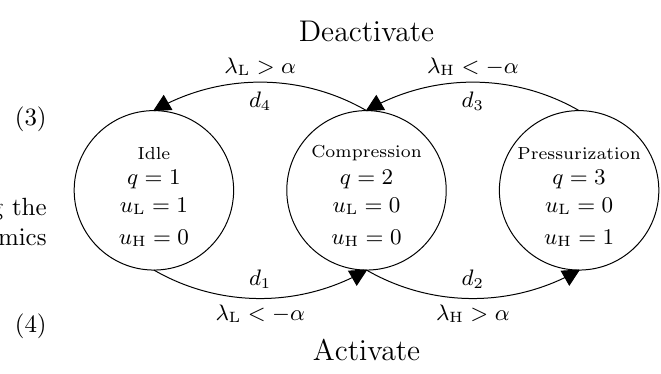
Figure 2: Hybrid automaton representation of valve control of the digital displacement